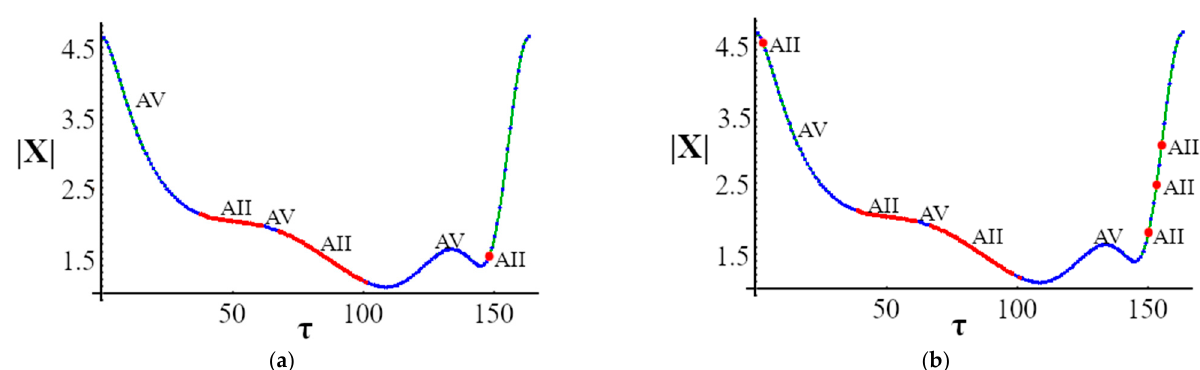
Figure 8. Power-shift method from AIII at ( a ) Y 0 = 1.63 transitioning to coexisting AII and AV via Y PS = 1.84 , and ( b ) Y 0 = 1.72 transitioning to coexisting AII and AVI via Y PS = 1.96.